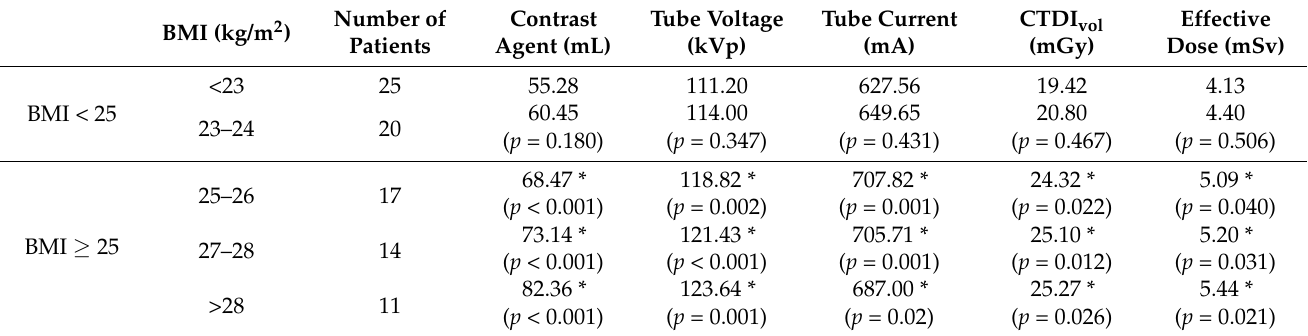
Table 2. Comparison of contrast agent doses, scan parameters, and radiation doses in different BMI groups.